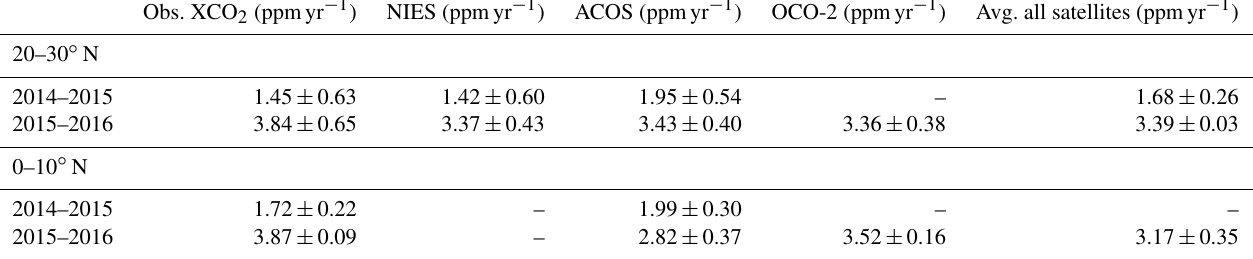
Table 4. Increase of XCO 2 between peaks of consecutive years and the standard error of the difference seen by obs. and satellite XCO 2 of GOSAT (NIES, ACOS) and OCO-2 between 2014 and 2017. Peak values are defined as the mean of the three consecutive highest monthly averages during spring of each year. In 2016, the mean of ACOS and that of obs. XCO 2 at 0–10 ◦ N is based on 2 months due to limited data. “–” indicates missing data. The right column shows the average increase of all satellite means and its standard deviation. Obs. XCO 2 (ppmyr − 1